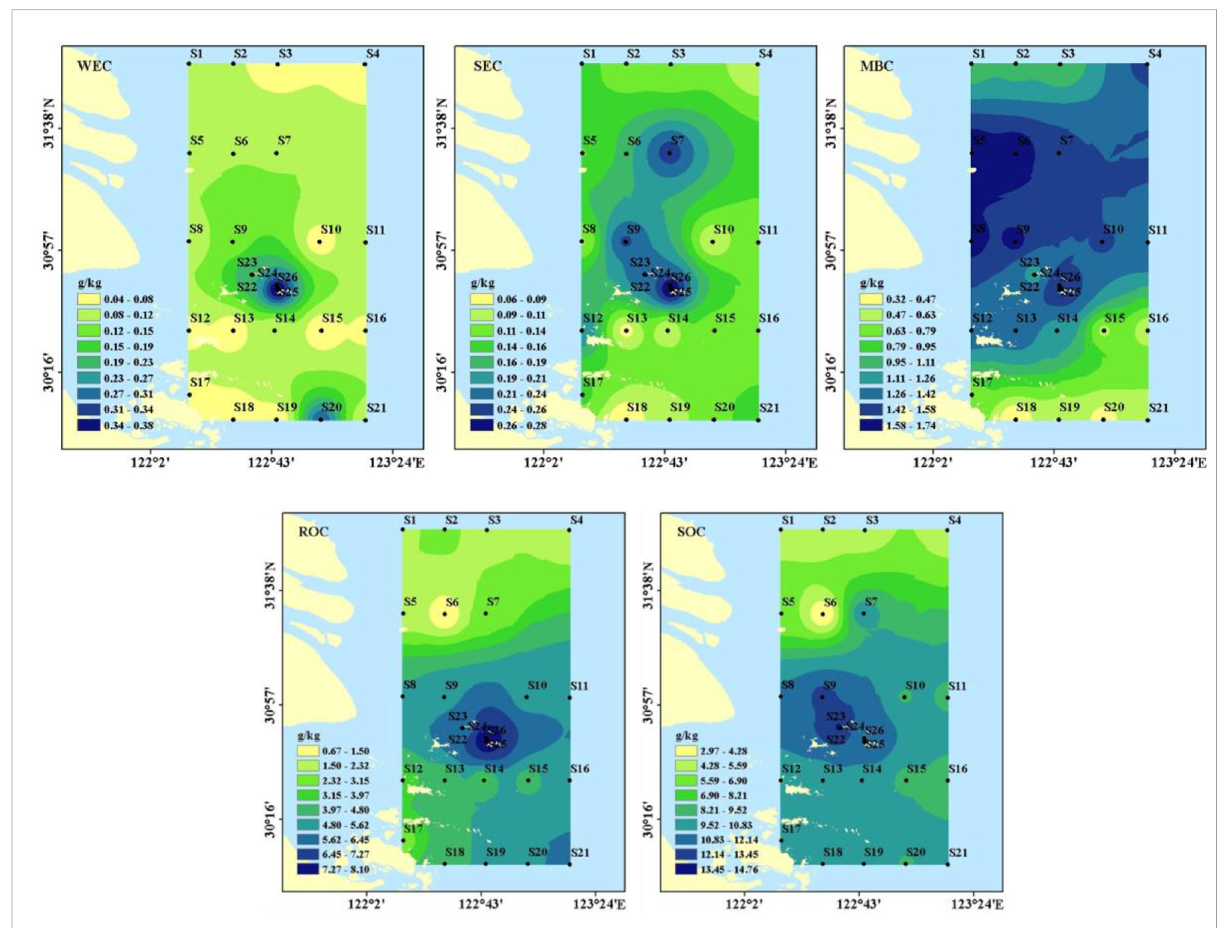
FIGURE 4 The four operational fractions and SOC in the surface sediments off the Changjiang Estuary and adjacent